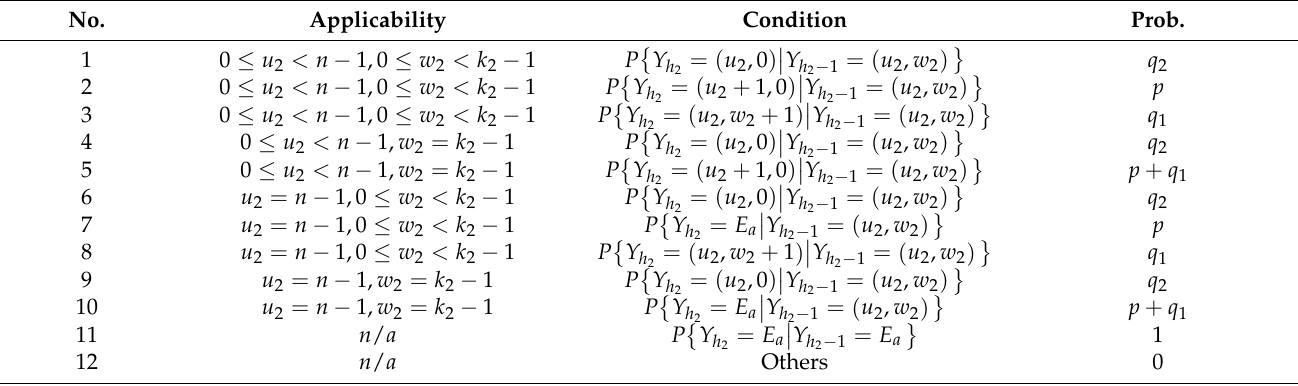
Table 2. Transition probabilities in Λ 2